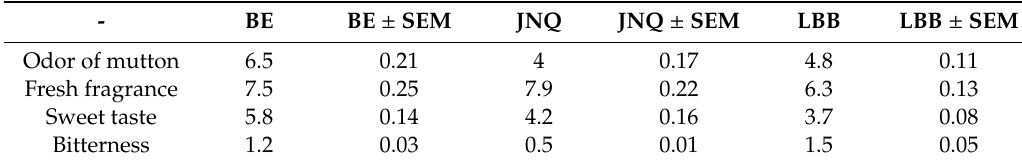
Table 2. Sensory test on all goat meat samples.